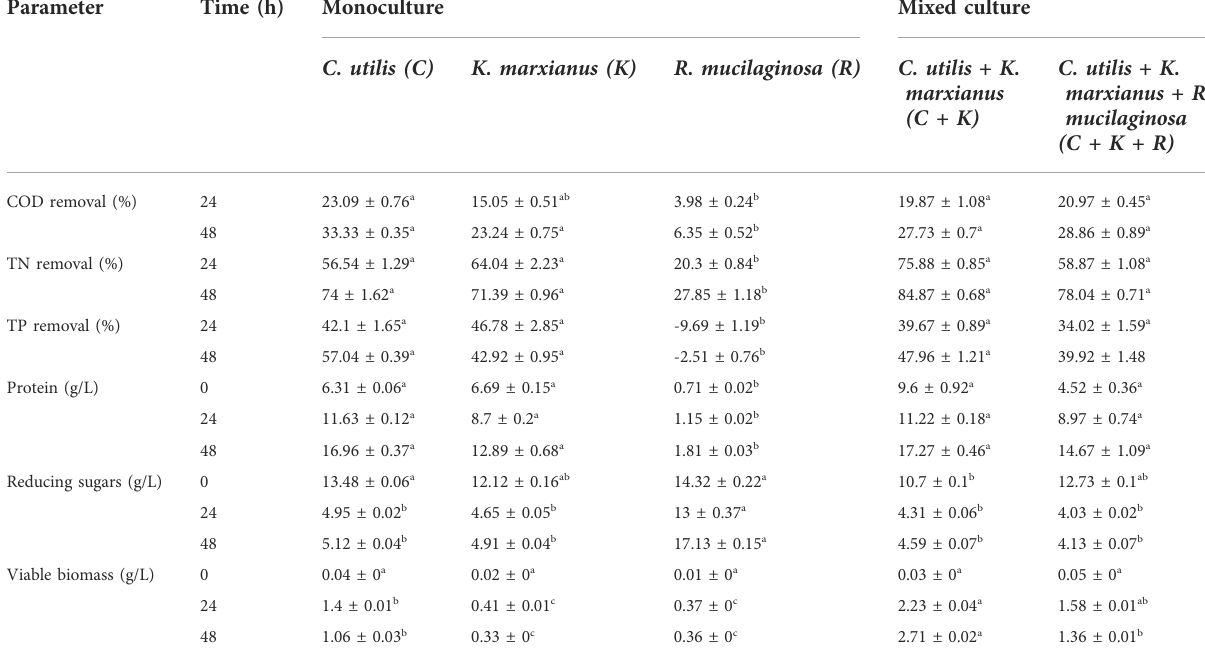
TABLE 1 Pollutant removal and revalorization potential of TV through fi ve different yeast culture